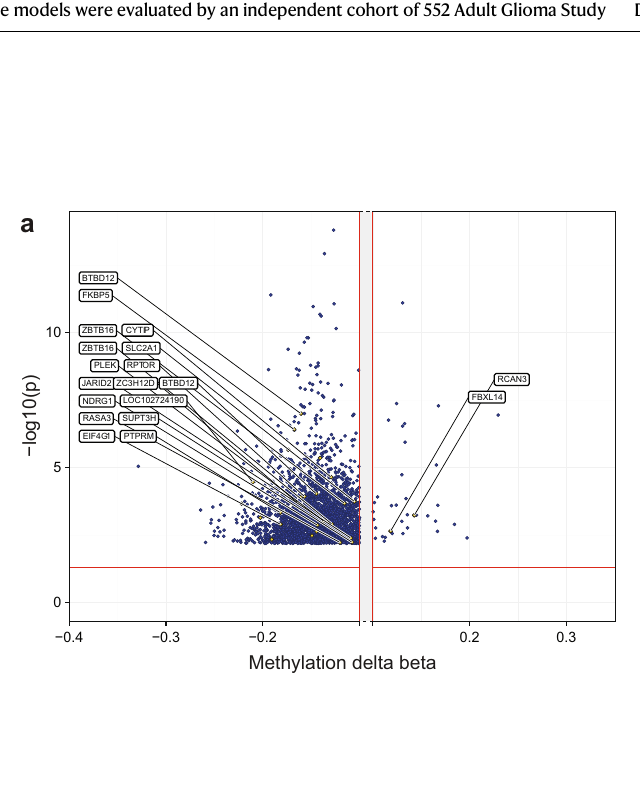
(AGS)casesandcontrols.Fourth,the NDMImodelwasevaluated as apredictorfor survival in 429 AGS glioma cases of which 172 were exposed to DEX and 257 were